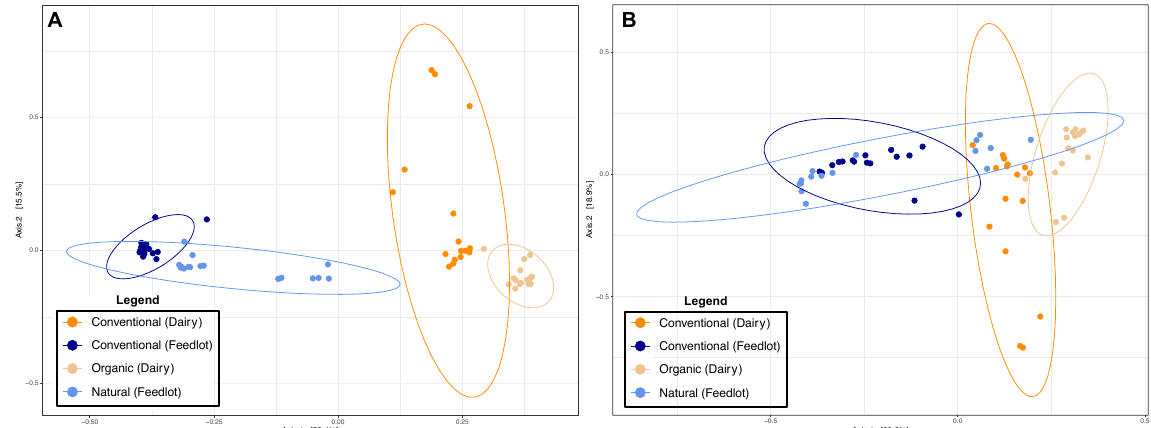
Figure 6. PCoAs showing the distribution of samples according to ARGs ( A ) and ISs ( B ). Sam- ples are colored according to the production type and practice (dairy, feedlot, conventional, and organic/natural). The ellipses represent a 95% confidence interval.